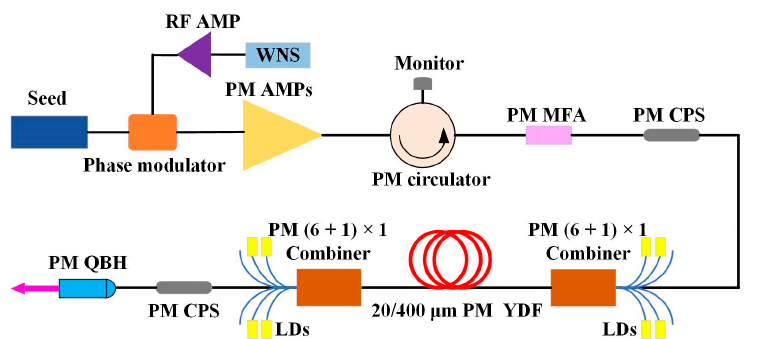
Figure 1. Schematic of the experimental setup. WNS, white noise signal; RF AMP, radio-frequency amplifier; PM AMPs, polarization-maintained pre-amplifiers; PM MFA, polarization-maintained mode field adaptor; PM CPS, polarization-maintained cladding power stripper; LDs, laser diodes; PM YDF, polarization-maintained Yb-doped fiber; PM QBH, polarization-maintained quartz block holder.